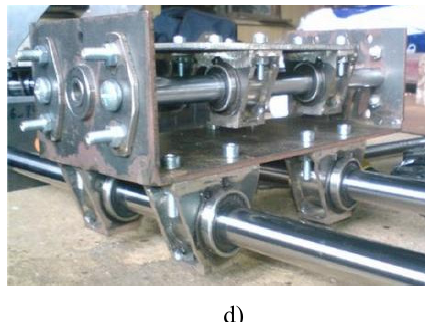
Figure 1. Linear cylindrical plain bearings